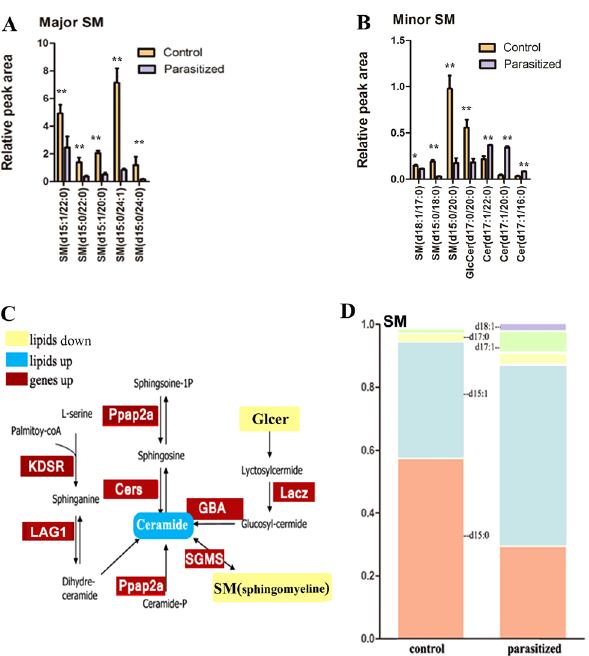
Figure 5. Changes in the gene expression and lipid composition in the sphingomyelin metabolism. ( A , B ) Quantification of the relative peak area of major sphingomyelin ( A ) and middle sphingomyelin ( B ) lipid species in parasitized and control aphids. Data are means ± SEM; n = 6/group. *** p < 0.01. ( C ) The sphingomyelin metabolism is induced in A . gossypii after exposure to cold conditions. Select sphingomyelin metabolites in the KEGG pathway, were significantly regulated in parasitized aphids. Red boxes indicate increased gene expression levels in parasitized insects and blue boxes indicate the high expression levels of sphingomyelin components. Cers , ceramide synthetase; KDSR , 3-dehydrosphinganine reductase; SGMS , shingomyelin synthase; Lacz , beta- galactosidase; GBA , glucosylceramidase. ( D ) Sphingomyelin base chemistry and fatty acyl chains in parasitized and control aphids. Data are means ± SEM (n =